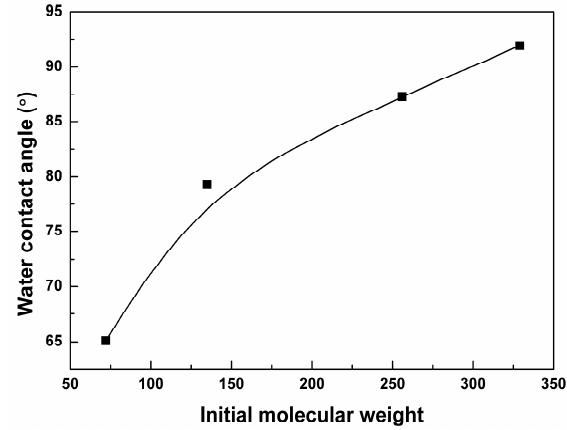
Figure 3. The water contact angle of 0.1 mol % BTB cross-linked PTMC-Ns was a function of the initial molecular weight.